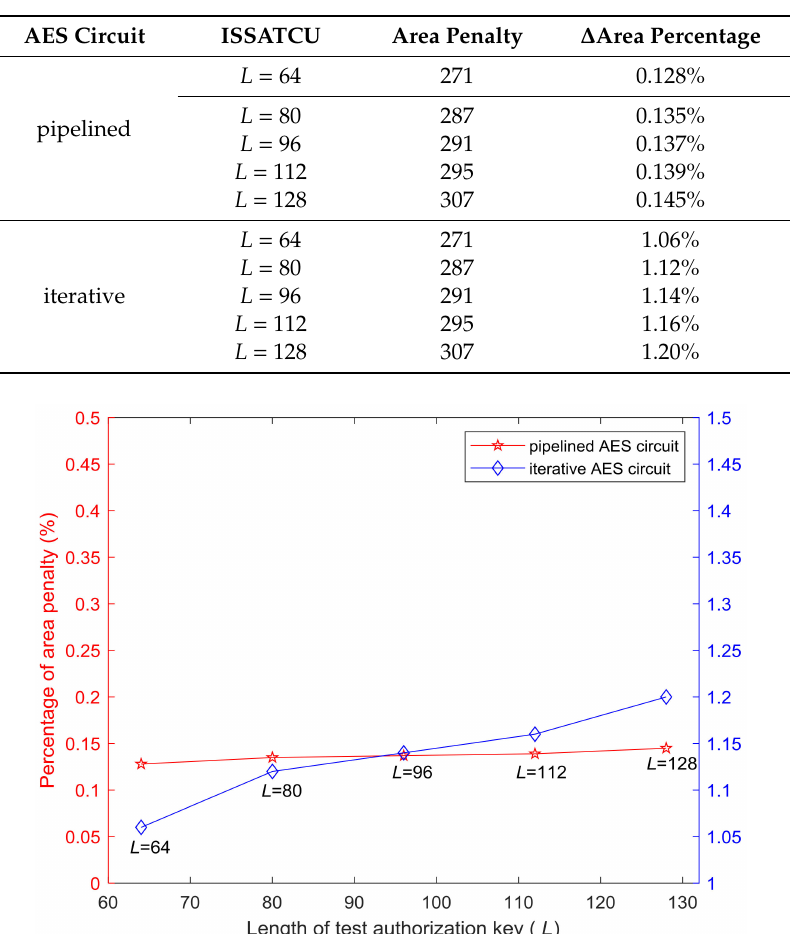
Table 2. Percentage area penalty of proposed ISSATCU.